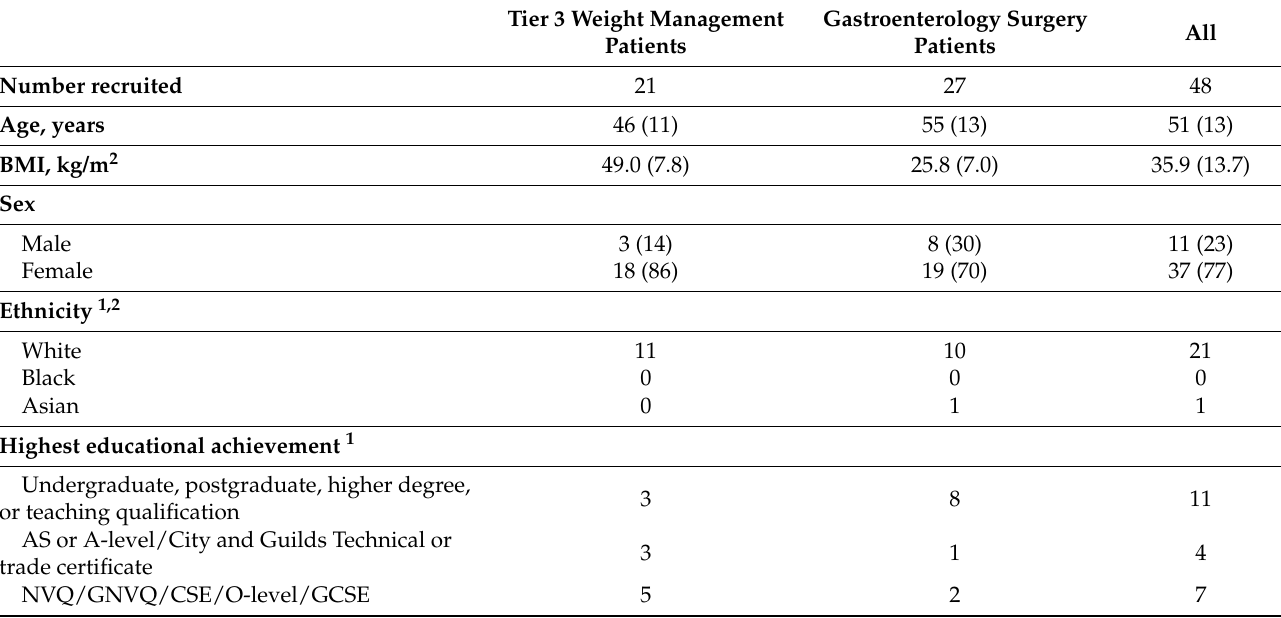
Table 1. Participant characteristics at